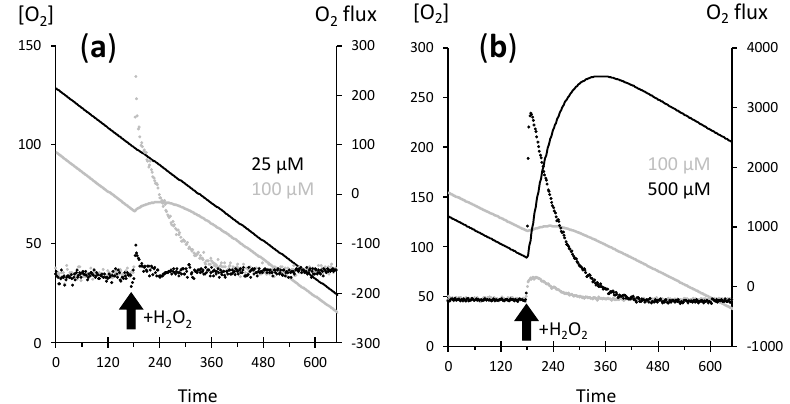
Figure 1. O 2 release upon H 2 O 2 addition. Chinese hamster ovary (CHO) cells suspension at approx. 2 × 10 6 cells / mL; X axis = time in seconds; left Y axis = recorded oxygen concentration expressed in µM (lines); right Y axis = oxygen flux rate in pmol / (s.mL) calculated over a two second interval (dots); and thick upward black arrow = H 2 O 2 addition performed at time 180 s. The stable negative value of oxygen rate before H 2 O 2 addition is the oxygen consumption due to cellular respiration. Different H 2 O 2 additions are represented: ( a ) 25 µM (black symbols) or 100 µM (grey symbols) H 2 O 2 in the cellular suspension, ( b ) 500 µM (black symbols) or 100 µM (grey symbols) H 2 O 2 in the cellular suspension.